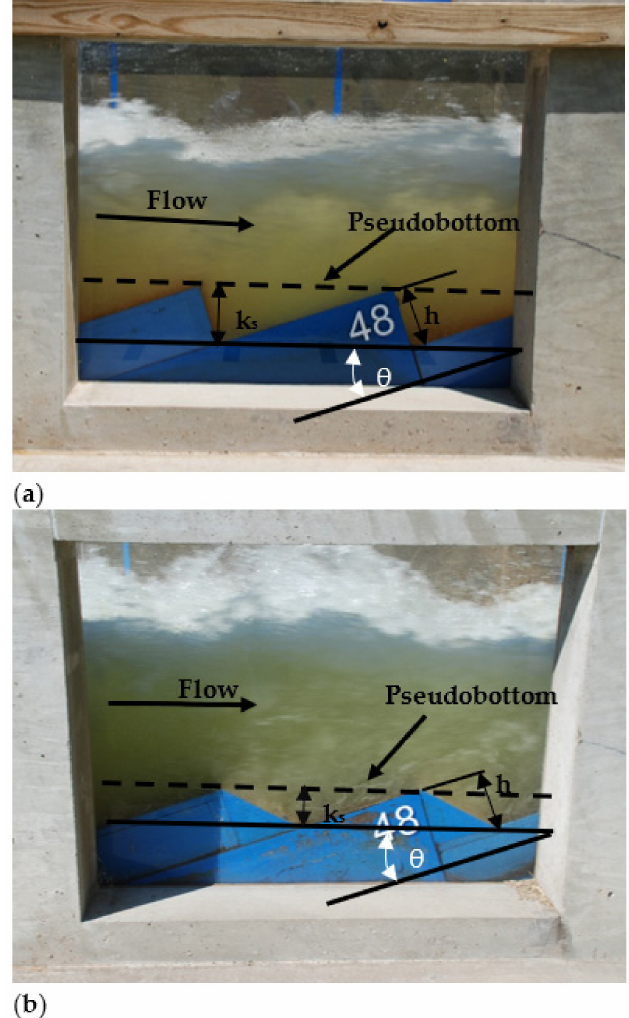
Figure 3. Skimming flow in a stepped chute model on a 3(H):1(V) slope ( θ = 18.4 ◦ ) with ( a ) traditional vertical face steps where k s = h cos( θ ) and ( b ) 45 ◦ beveled face steps where k s = 2/3 h cos( θ ) defined for this chute slope. Note photographs are oriented along the chute